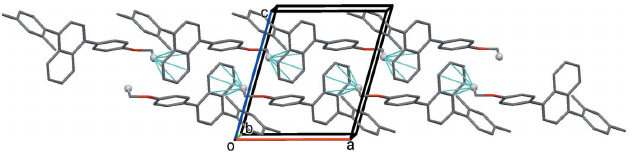
Figure 3 Hirshfeld surfaces mapped over ( a ) d norm , ( b ) electrostatic potential, ( c ) shape index and ( d ) curvedness and ( e ) fragment